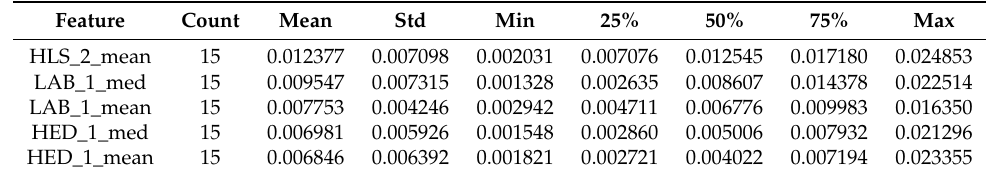
Table 4. Statistics for the five most important feature methods generated according to the boxplot in Figure 14.